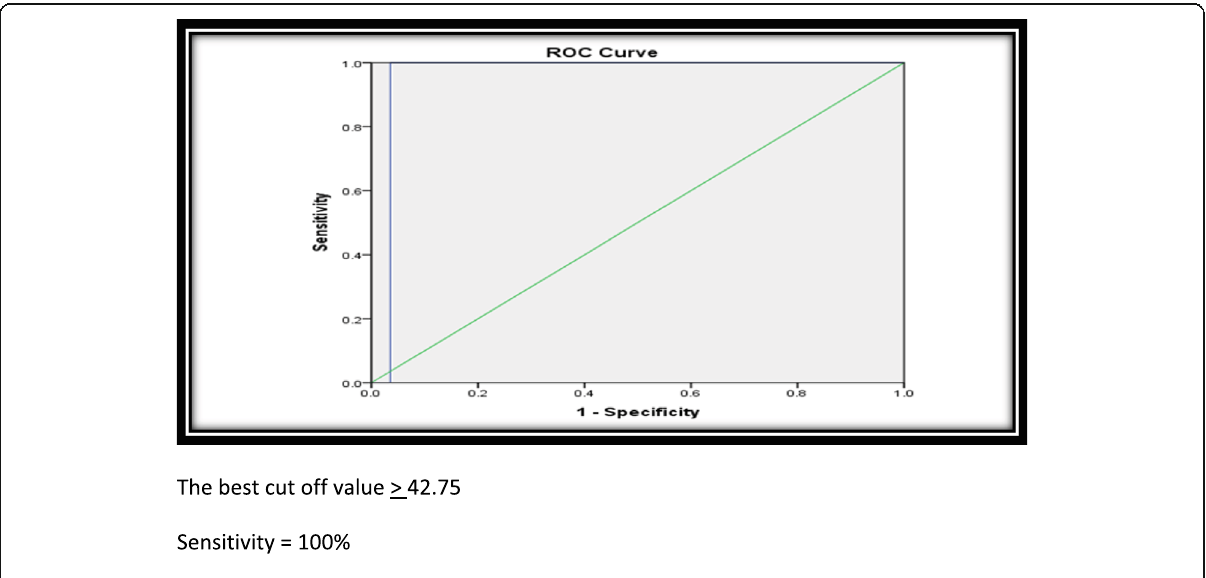
Fig. 2 Validity of LS measurement in prediction of death after 1 year. The best cutoff value ≥ 42.75, sensitivity = 100%, and specificity =